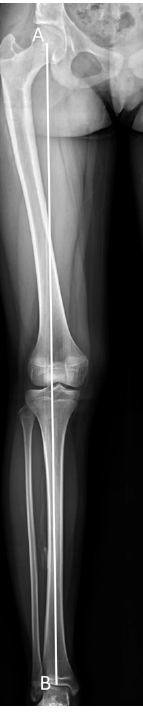
Figure 1. Radiological measurements. The superolateral angle between the mechanical axis of the femur and the joint surface of the femoral condyle was defined as the mechanical lateral distal femoral angle (mLDFA). The inferomedial angle between the anatomical axis of the tibia and the articular axis of the proximal tibia was labeled as the medial proximal tibial angle (MPTA). The mechanical axis deviation (MAD) was designated as the distance from the center of the knee to the mechanical axis of the lower leg. Mechanical axis = AB.